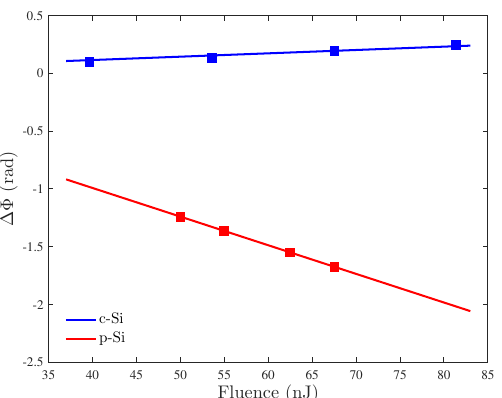
Figure 3. Nonlinear phase shift, ∆Φ , as a function of the incident fluence for c -Si (blue) and p -Si (red). The squares represent the experimental results, and the solid lines are calculated with n 2 obtained from the fitting results.